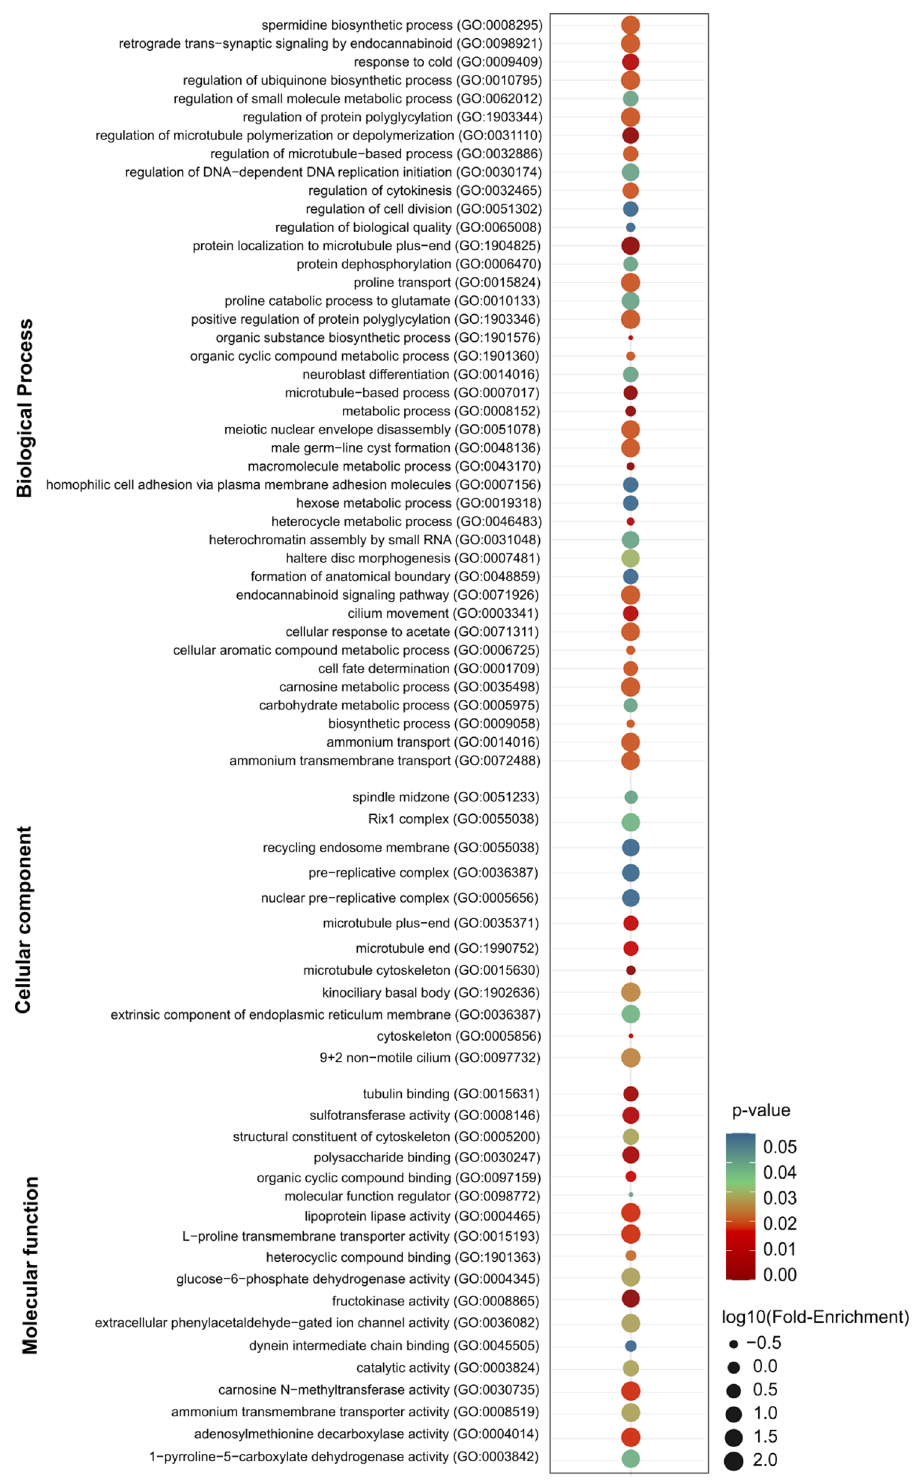
Figure 5. Functions of shared over- and underexpressed genes between H ♀ ari ♂ m wri and H ♀ ari ♂ m moj males. Dot plot representing GO enrichment for the biological process, cellular component and molecular function categories. The plot was generated using the ggplot2 package (version 3.3.3) in R 79